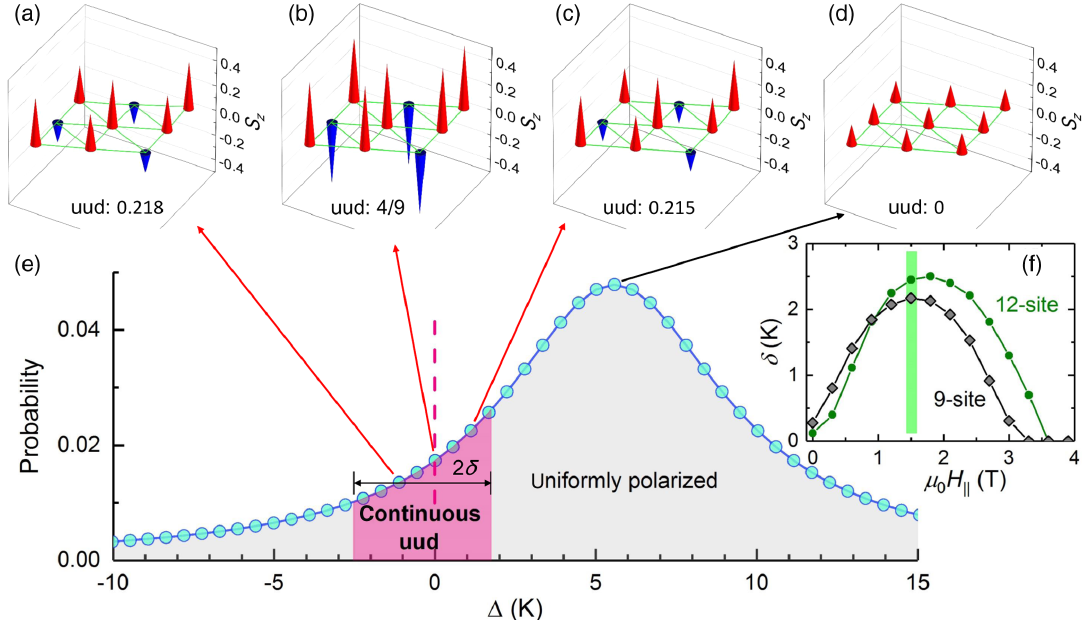
FIG. 3. 2D continuous uud order in TmMgGaO 4 calculated by the least- R optimized model no. 4 under an external longitudinal field, p μ 1 . 5 T. The 9-site cluster with PBC is used in the ED calculation. The calculated (Ising) magnetic dipole structures at selected 0 H k ¼ values of Δ ¼ E 2 − E 1 are shown in (a) – (d), respectively, with the numbers standing for the order parameter of the uud phase, as described in the text. (e) Lorentzian probability distribution of Δ , P ð Δ Þ . A fraction ( ∼ 11% ) of Tm 3 þ ions within the range of 2 δ (marked in red) give rise to the uud phase with the continuous distribution of the order parameter [see (a) – (c), for example], while the remaining large fraction marked by gray results in the uniform polarization of the spin system [see (d), for example]. (f) Field dependence of δ , δ ð H Þ , calculated using the same Hamiltonian parameters of the fitted model no. 4 (9-site ED) on the 9-site (black line) and 12-site (olive k line) clusters with